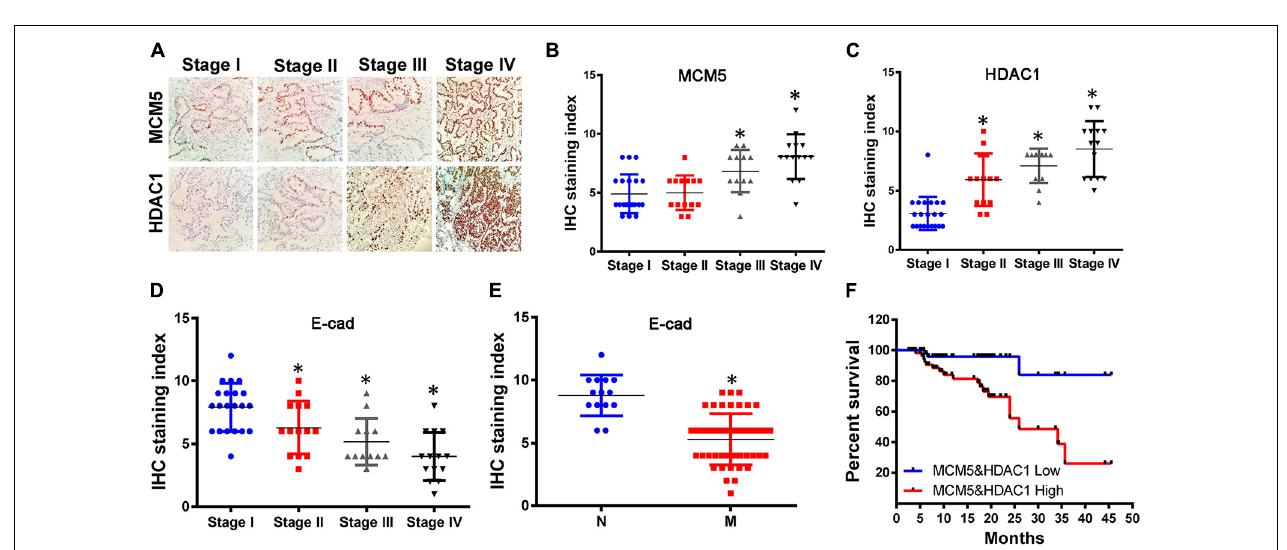
FIGURE 6 | MCM5/HDAC1 complex led to poor prognosis in lung cancer patients. Sixty-one clinical lung cancer tissues were collected and used to analyze MCM5, HDAC1, and E-cadherin expression, as well as their effect on survival rate. (A) Immunohistochemistry was performed to detect MCM5 and HDAC1 expression in lung cancer tissues at different clinical stages. (B) MCM5 expression in lung cancer patients. (C) HDAC1 expression in lung cancer patients. (D) E-cadherin expression in lung cancer tissues at different clinical stages. (E) E-cadherin expression in metastatic and non-metastatic lung cancer. (F) Kaplan–Meier plots of the overall survival rate of patients with lung cancer having low (blue) or high (red) MCM5/HDAC1 levels. * P <